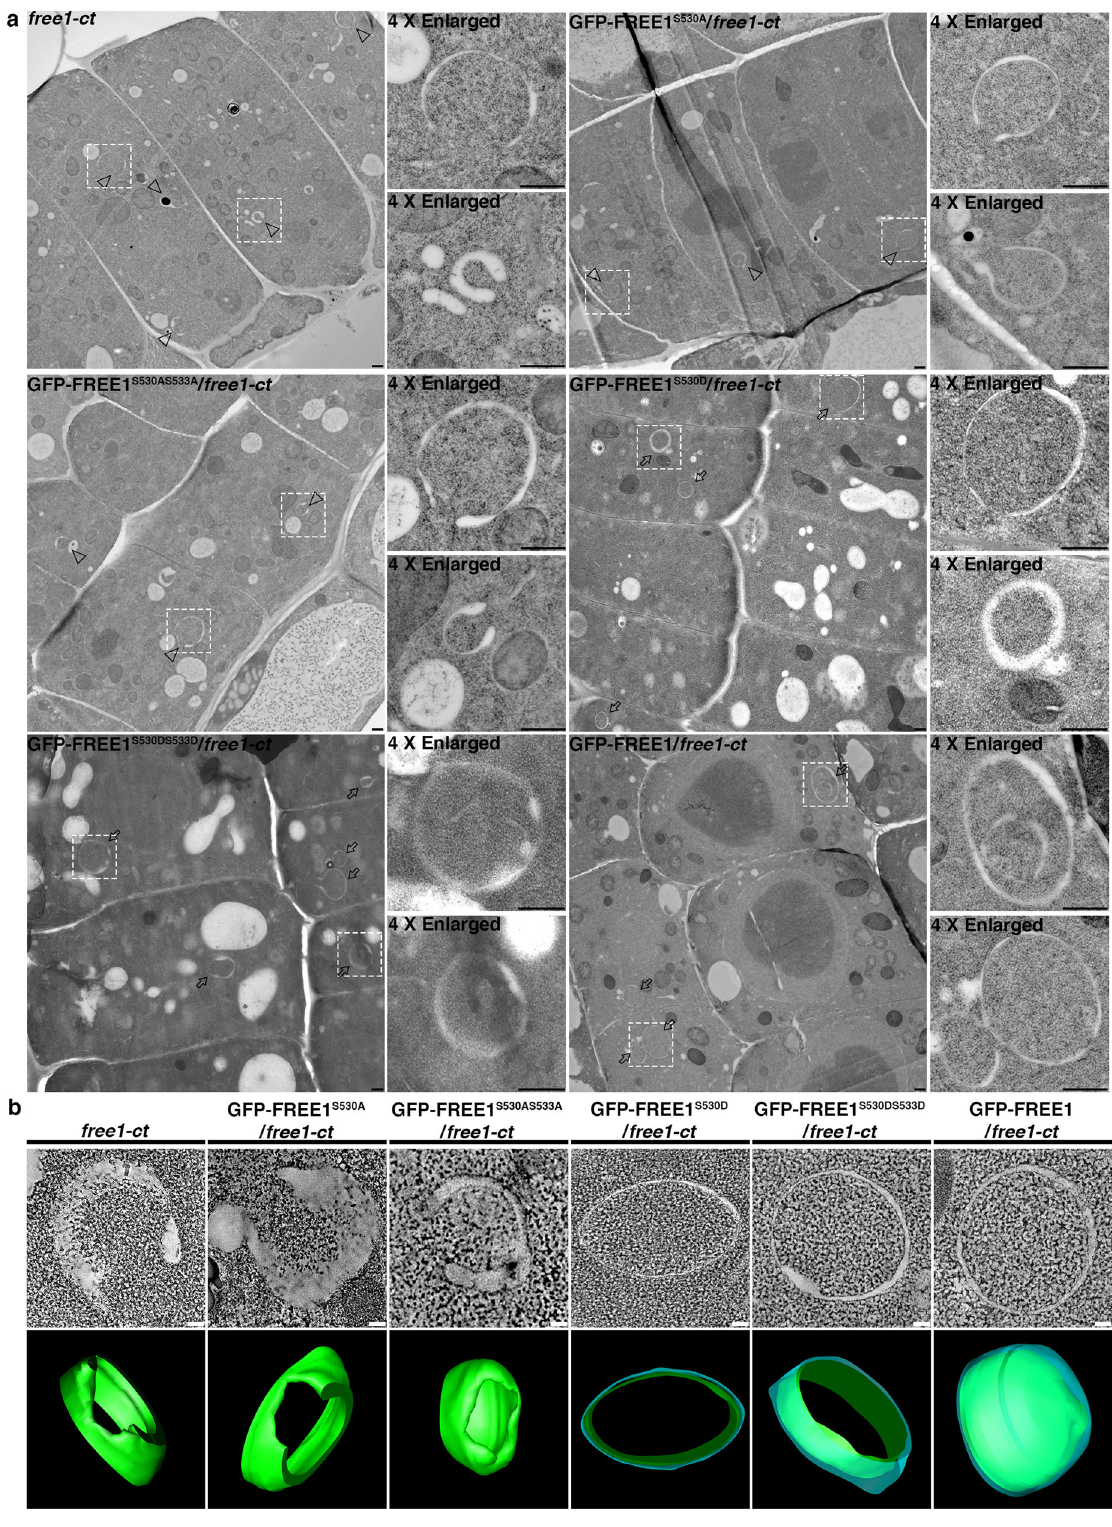
Fig. 5 | The phosphorylation site on FREE1 is essential for the autophagosome closure. a Structural TEM analysis of ultrathin sections prepared from high- pressure freezing/frozen substituted free1-ct mutant, GFP-FREE1 S530A / free1-ct , GFP- FREE1 S530AS533A / free1-ct , GFP-FREE1 S530D / free1 -ct, GFP-FREE1 S530DS533D / free1 -ct, and GFP- FREE1/ free1-ct transgenic plant root tips upon carbon starvation for 18h. White dash boxes indicate the 4 X zoom-in areas. Arrowheads indicate examples of the unsealedautophagosomalstructures,whilearrowsindicateexamplesofthesealed autophagosomes. Scale bars, 500nm. b 3D electron tomography (ET) analysis of